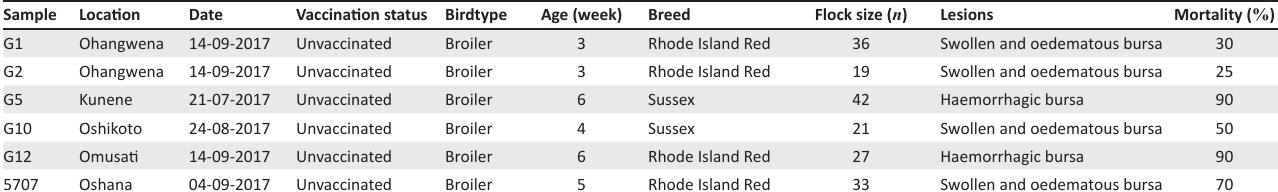
TABLE 1: Description of samples analysed in this study. Sample